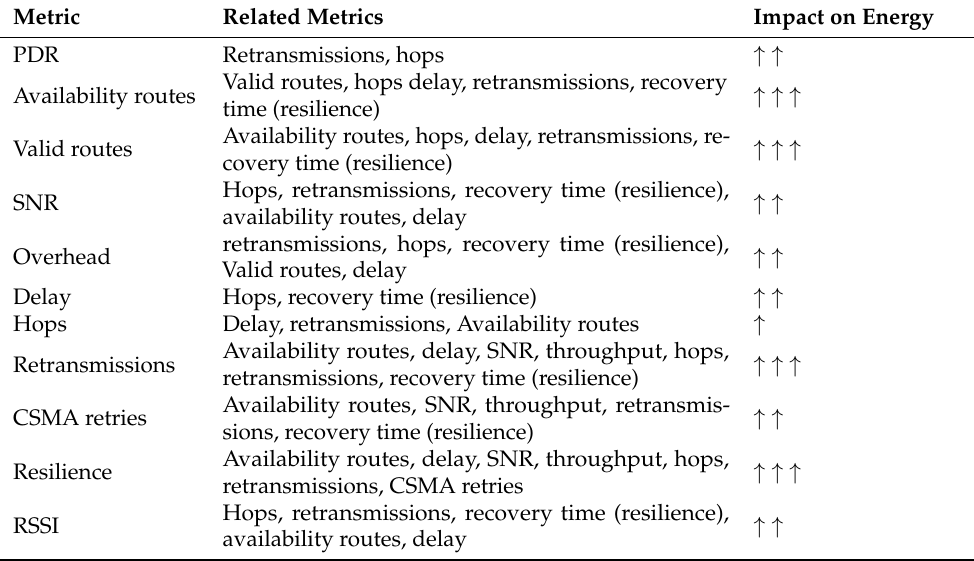
Table 5. Relationship between metrics and impact on energy.